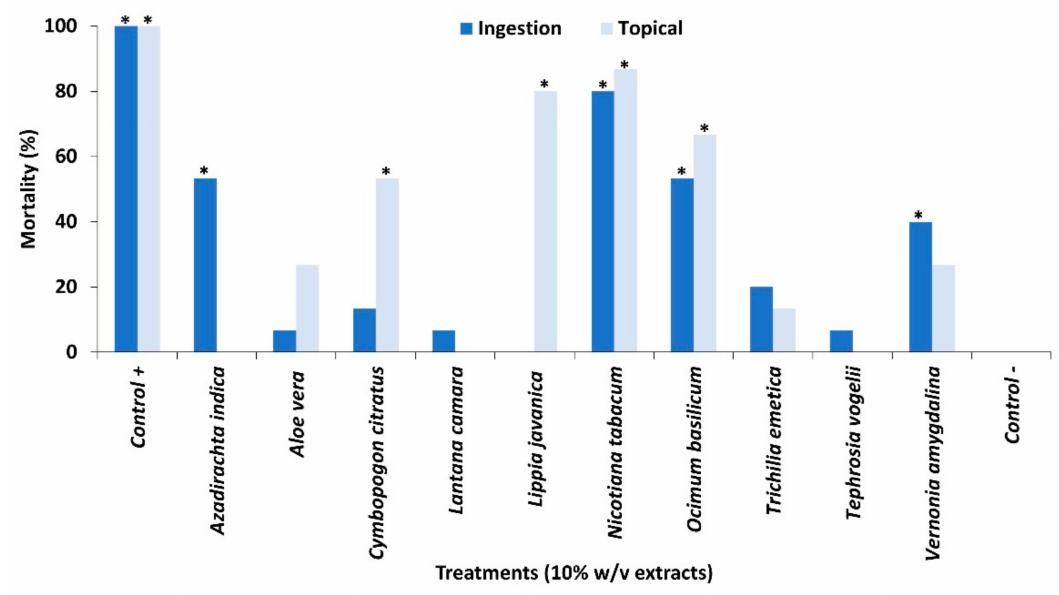
Figure 1. Mortality of 2nd instars when exposed to extracts of pesticidal plant either topically applied through a contact toxicity bioassay or through ingestion in a feeding bioassay. Treatments di ff erent from the untreated control ( p < 0.05) are indicated by *. Significant di ff erences are presented in Table